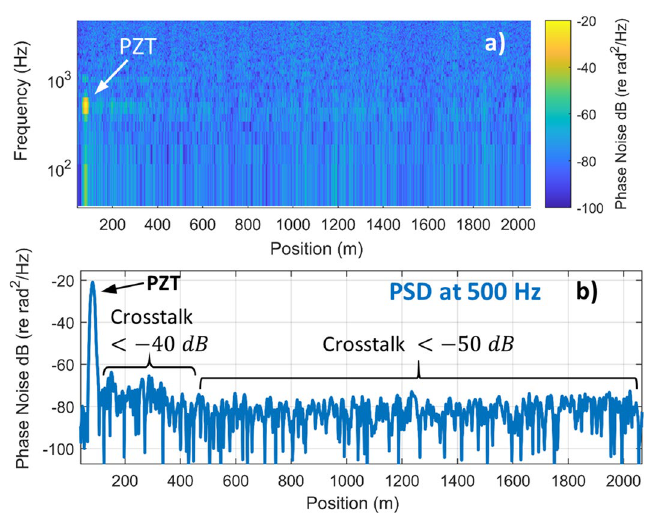
Figure 8. Crosstalk performance ( a ) Spectrogram showing the first 2100 m of a 10 km FUT with a PZT near the beginning of the fiber. ( b ) Cross-section of the PSD at 500 Hz as a function of position in the fiber. The PZT signal was suppressed by at least 40 dB in the first 400 m of fiber and by at least 50 dB in the rest of the